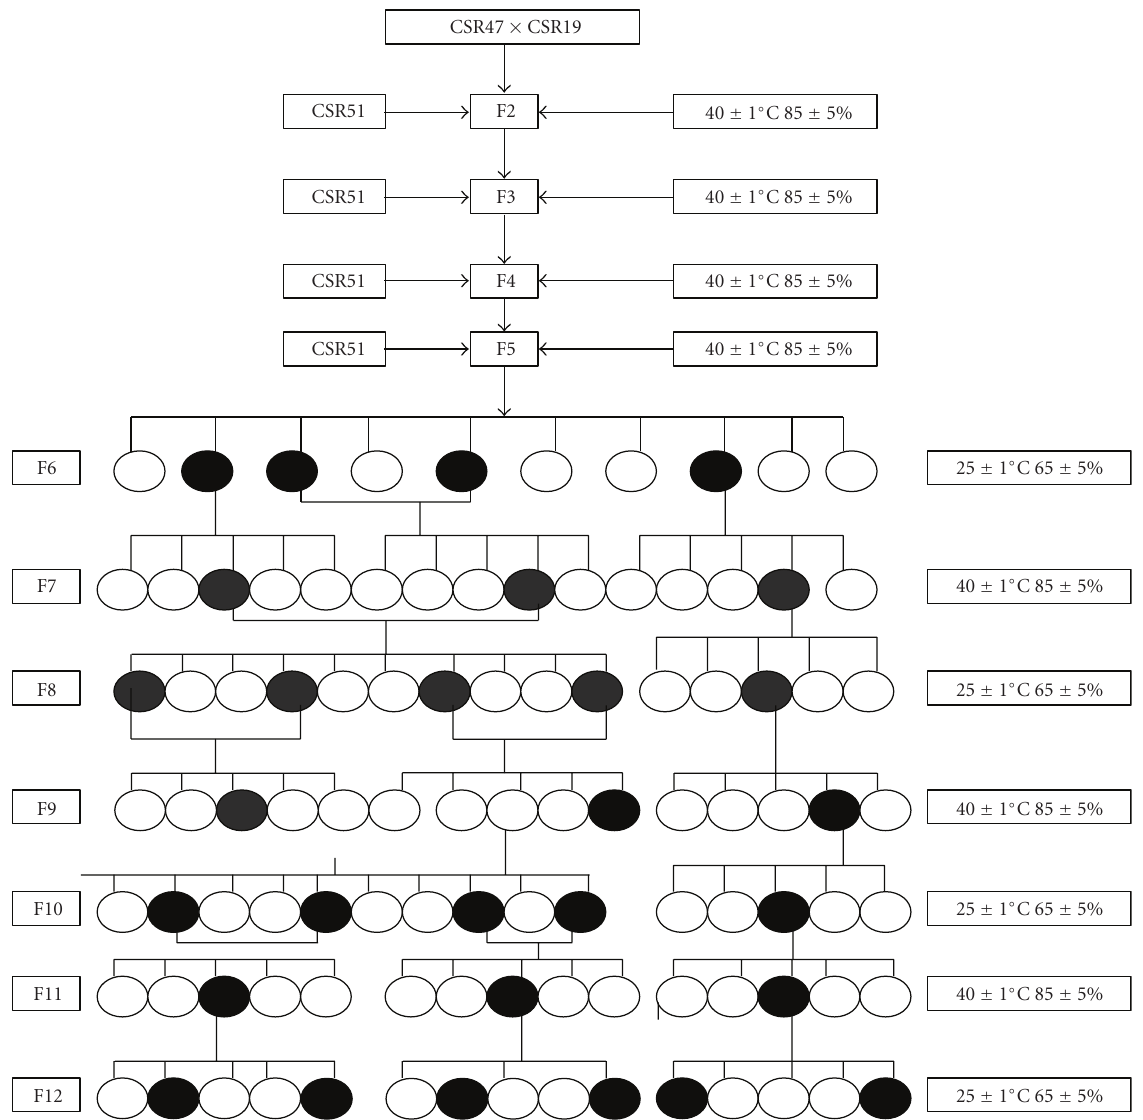
Figure 1: Breeding plan for